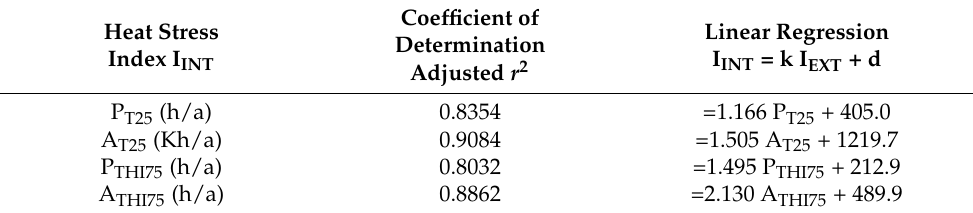
Table 2. Linear regression results of vector I INT = [P T25 , A T25 , P THI75 , A THI75 ] (calculated by the indoor parameters) as a function of the vector I EXT = [P T25 , A T25 , P THI75 , A THI75 ] (calculated by weather data) with the coefficient of determination r 2 of the linear regression with the slope k and the intercept d. The p -values are <0.001.